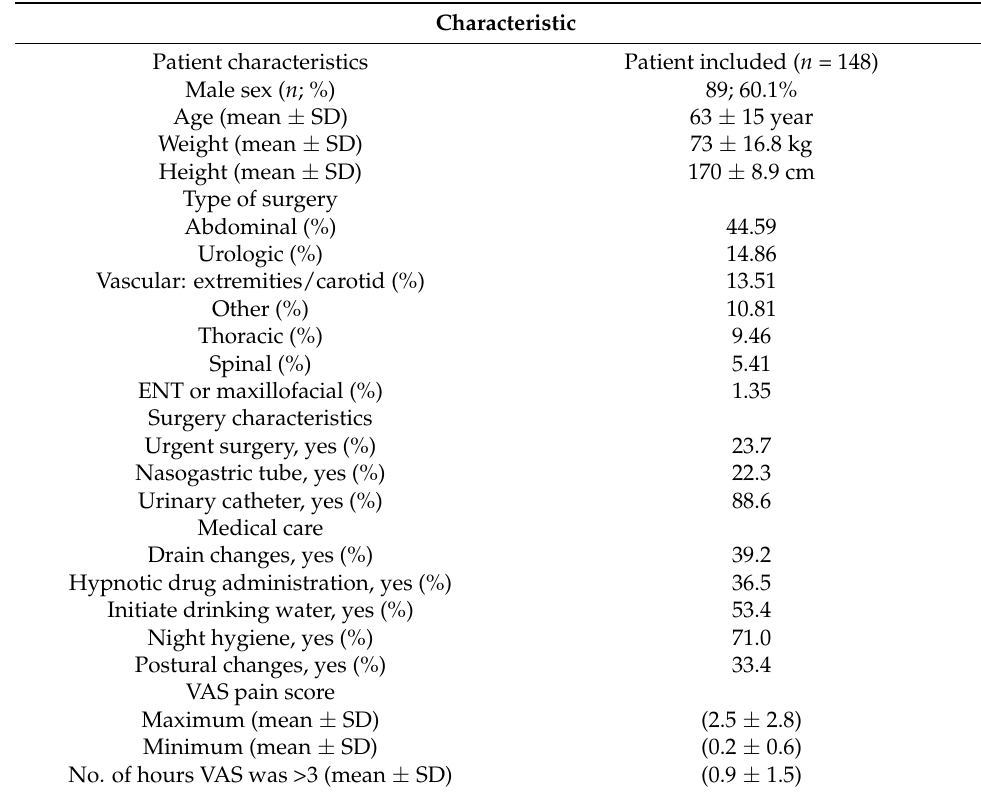
Table 1. Patient characteristics on